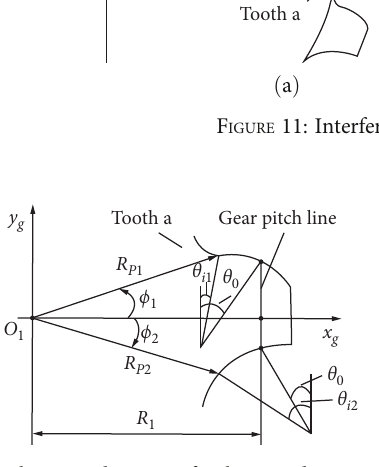
F IGURE 12: Schematic diagram of polar coordinates of tooth a.